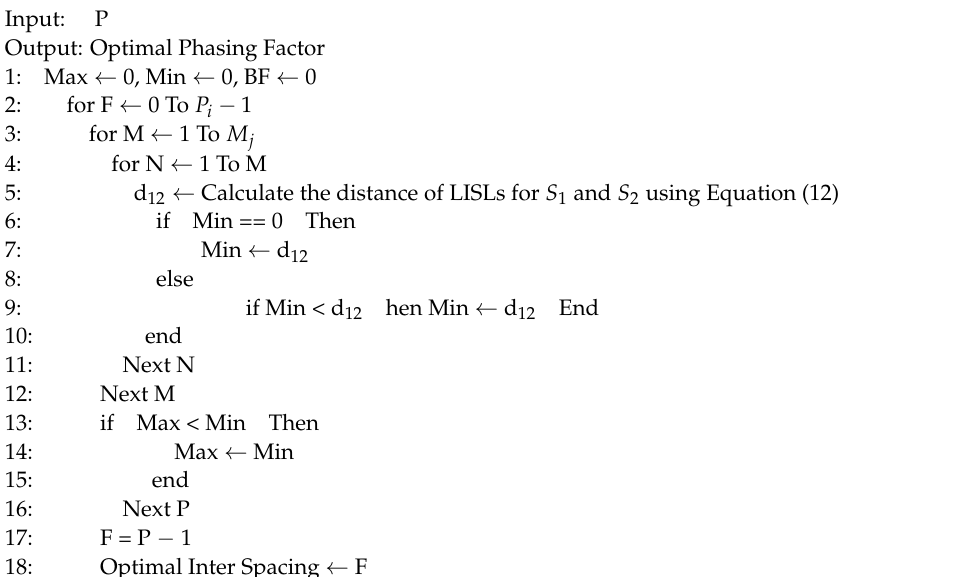
Algorithm 1 Pseudocode for optimal phasing factor solution